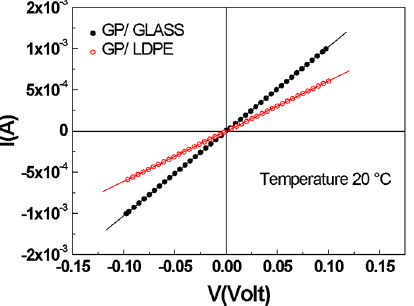
Figure 8. I-V characteristics of the GP films deposited on glass (black circle symbols) and LDPE (red circle symbols) substrates. The straight lines fit the experimental data.